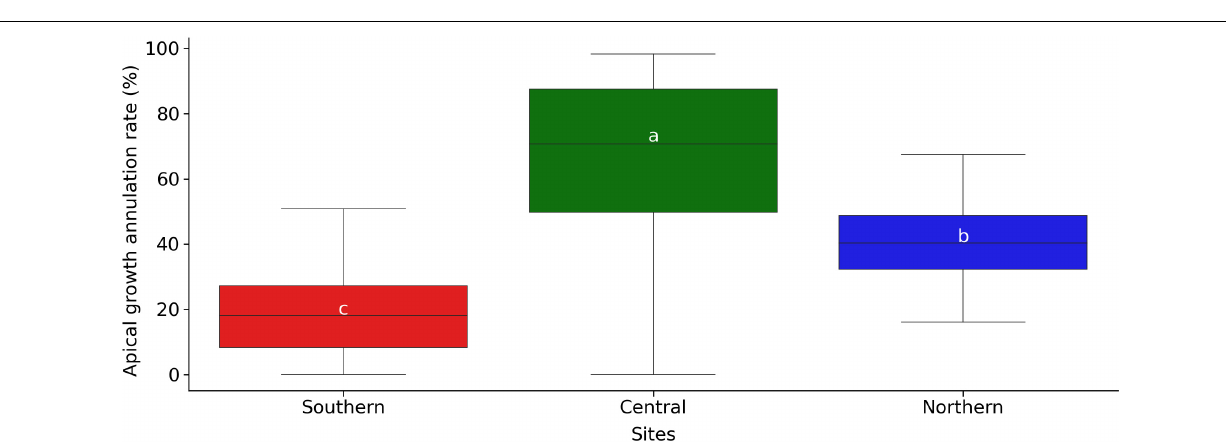
FIGURE 8 | Annual growth cancelation rate (%) after the late-spring frost of 2021 in the three plantation test sites. The horizontal line inside the boxes marks the median for the observations, the box ends indicate the upper (third) to lower (first) quartiles of the value ranges, and the whiskers indicate the highest and lowest observations. Means with the same letter indicate no significant differences with P ≥